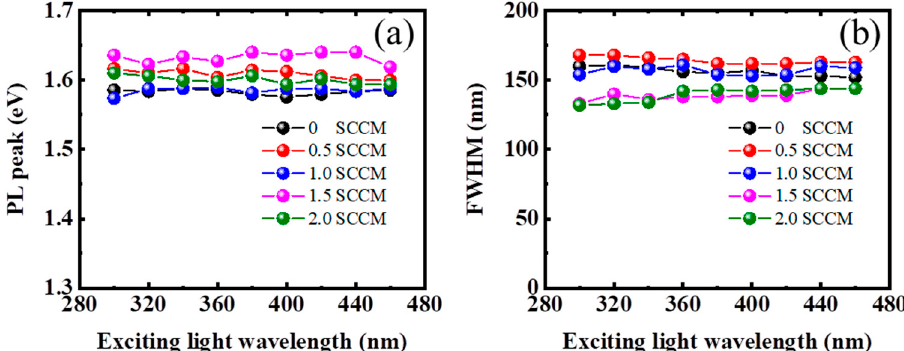
Figure 2. Emission peak position ( a ) and the full width at half maximum ( b ) with the variation of the excitation wavelength for the films prepared at different NH 3 flow rates, respectively.